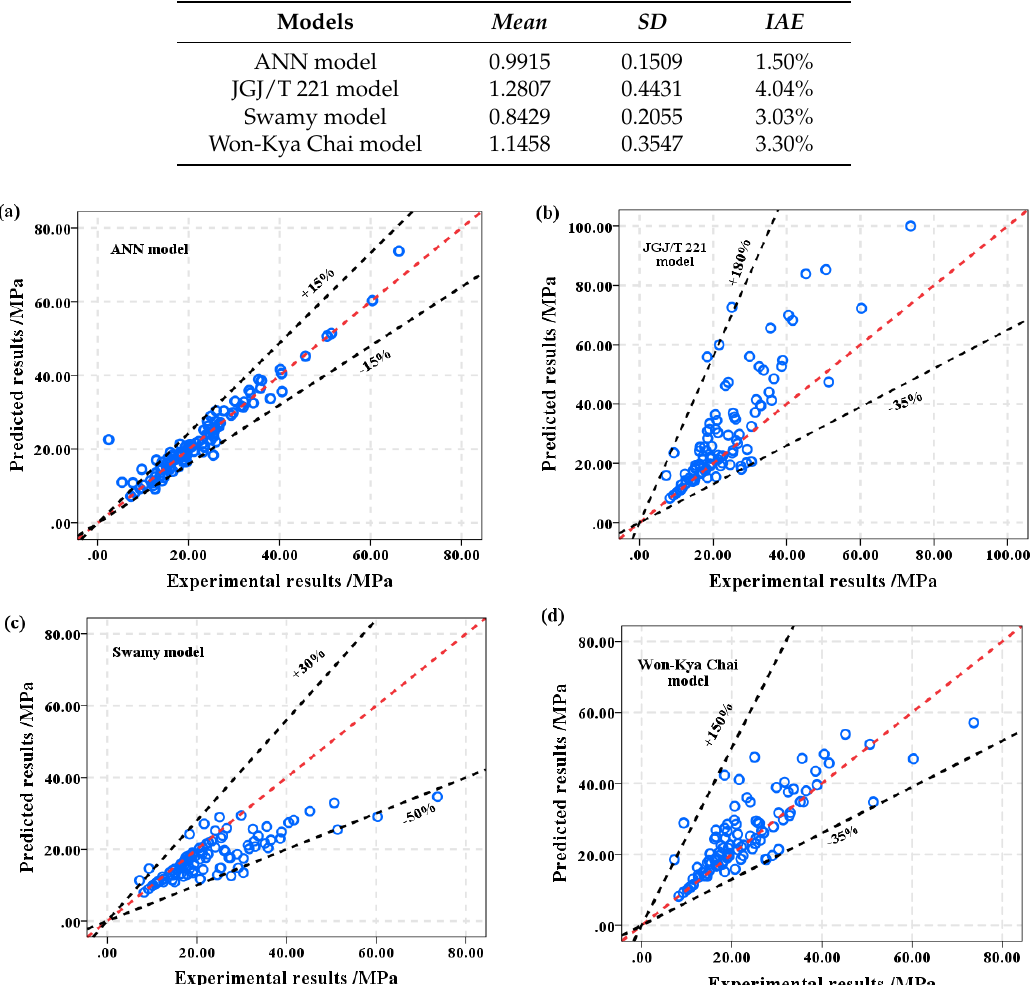
Figure 6. Comparison between predicted values and experimental values from three analytical models (proposed by JGJ/T 221, Swamy, Won-Kya Chai) in previous studies and the ANN model studied in this paper. The 45 degree diagonal line (red line) denotes the predicted values equal to the experimental values and the black lines denote that the maximum ranges between predicted results and experimental results. Table 10. The Mean value, SD, and IAE of ANN model and analytical models.